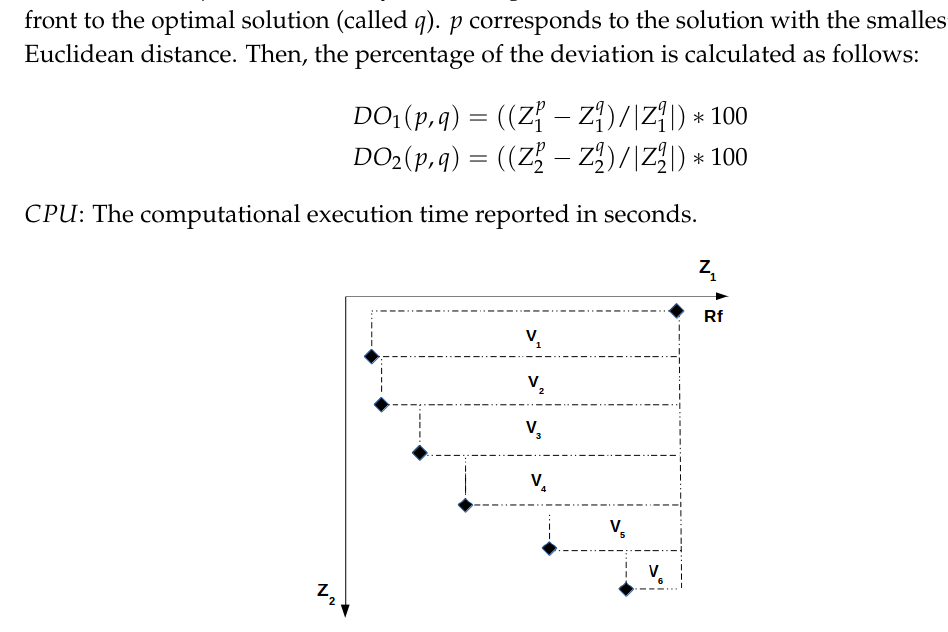
Figure 5. Hyper-volume for Z 1 and Z 2 of the Vehicle Routing Problem with Time Windows, Synchronization, and Precedence constraints